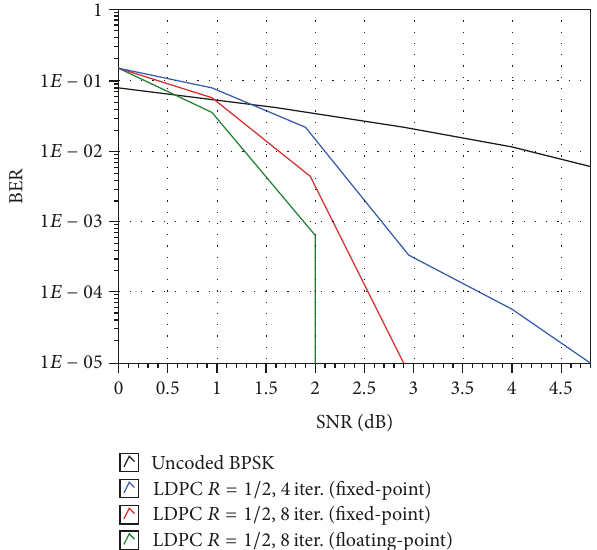
Figure 10: BER performance comparison between uncoded BPSK (rightmost), rate = 1/2 LDPC with 4 iterations using fixed-point data representation(secondfromright),rate=1/2LDPCwith8iterations using fixed-point data representation (third from right), and rate = 1/2 LDPC with 8 iterations using floating-point data representation (leftmost).